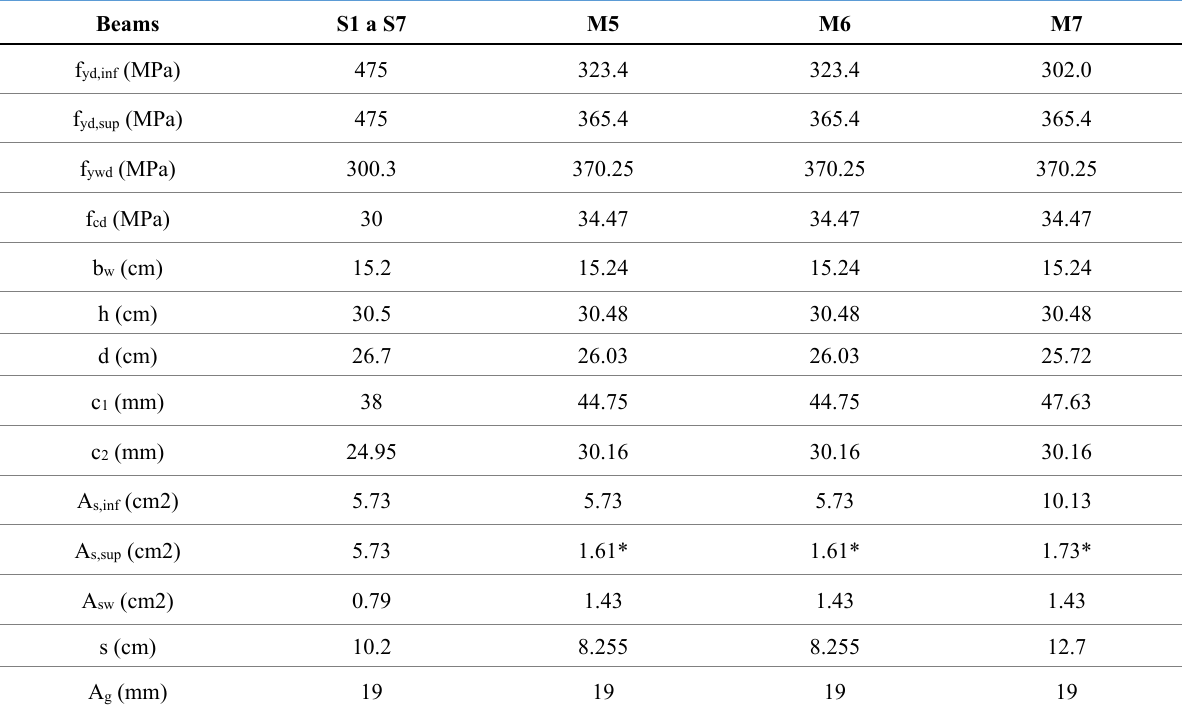
Table 1: Other beams’ parameters [20], [21]. *Areas multiplied by